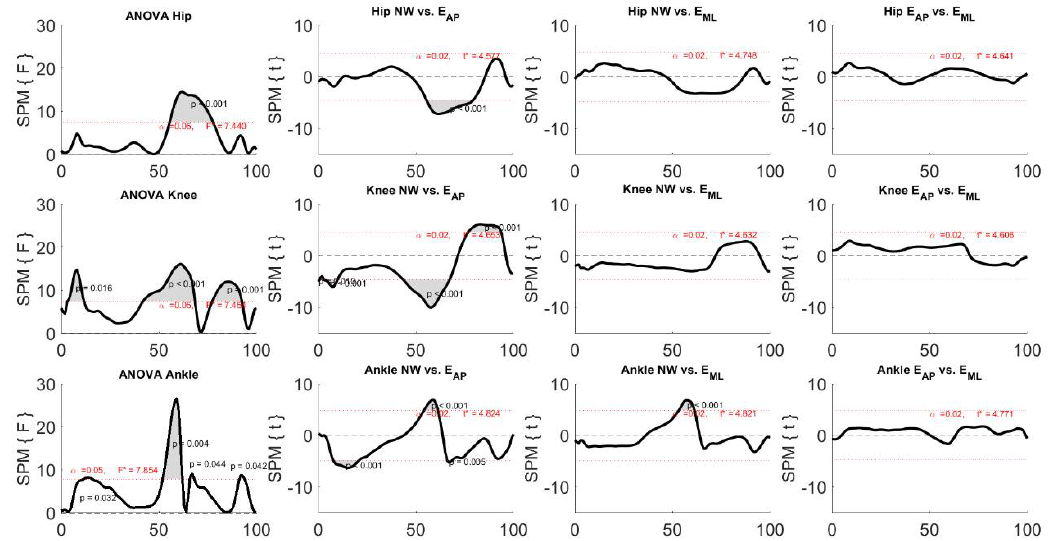
Figure 4. Results of the one-way repeated measurement ANOVA SPM and related post-hoc analysis for the joint angle curves. Black, bold lines indicate the statistical maps and the dotted, red lines indicate the critical thresholds, whereas the grey areas indicate the significant difference among independent variables, i.e., the three motion tasks. F* and t* indicate the F-value and t-value for ANOVA and t-tests, respectively.